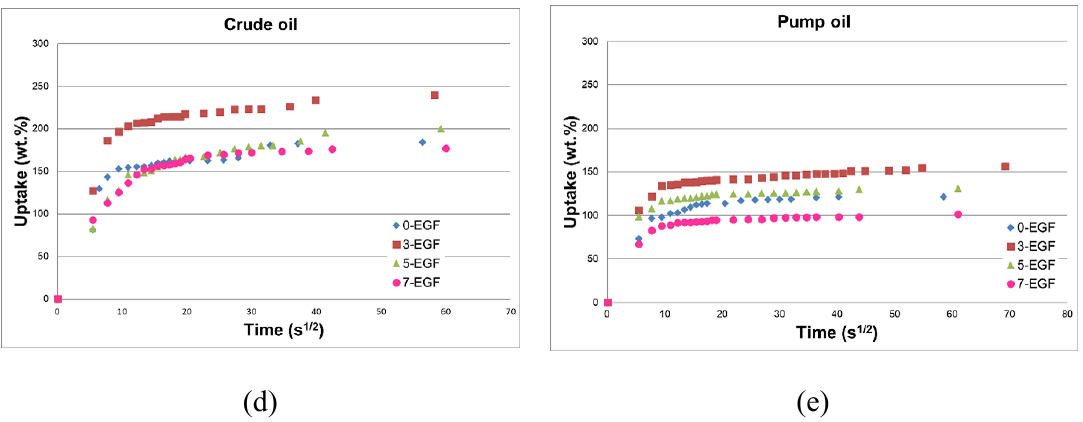
Figure 2. Foam absorption capacities for the investigated oils: ( a ) water, ( b ) kerosene, ( c ) virgin naphtha, ( d ) crude oil and ( e ) pump oil.